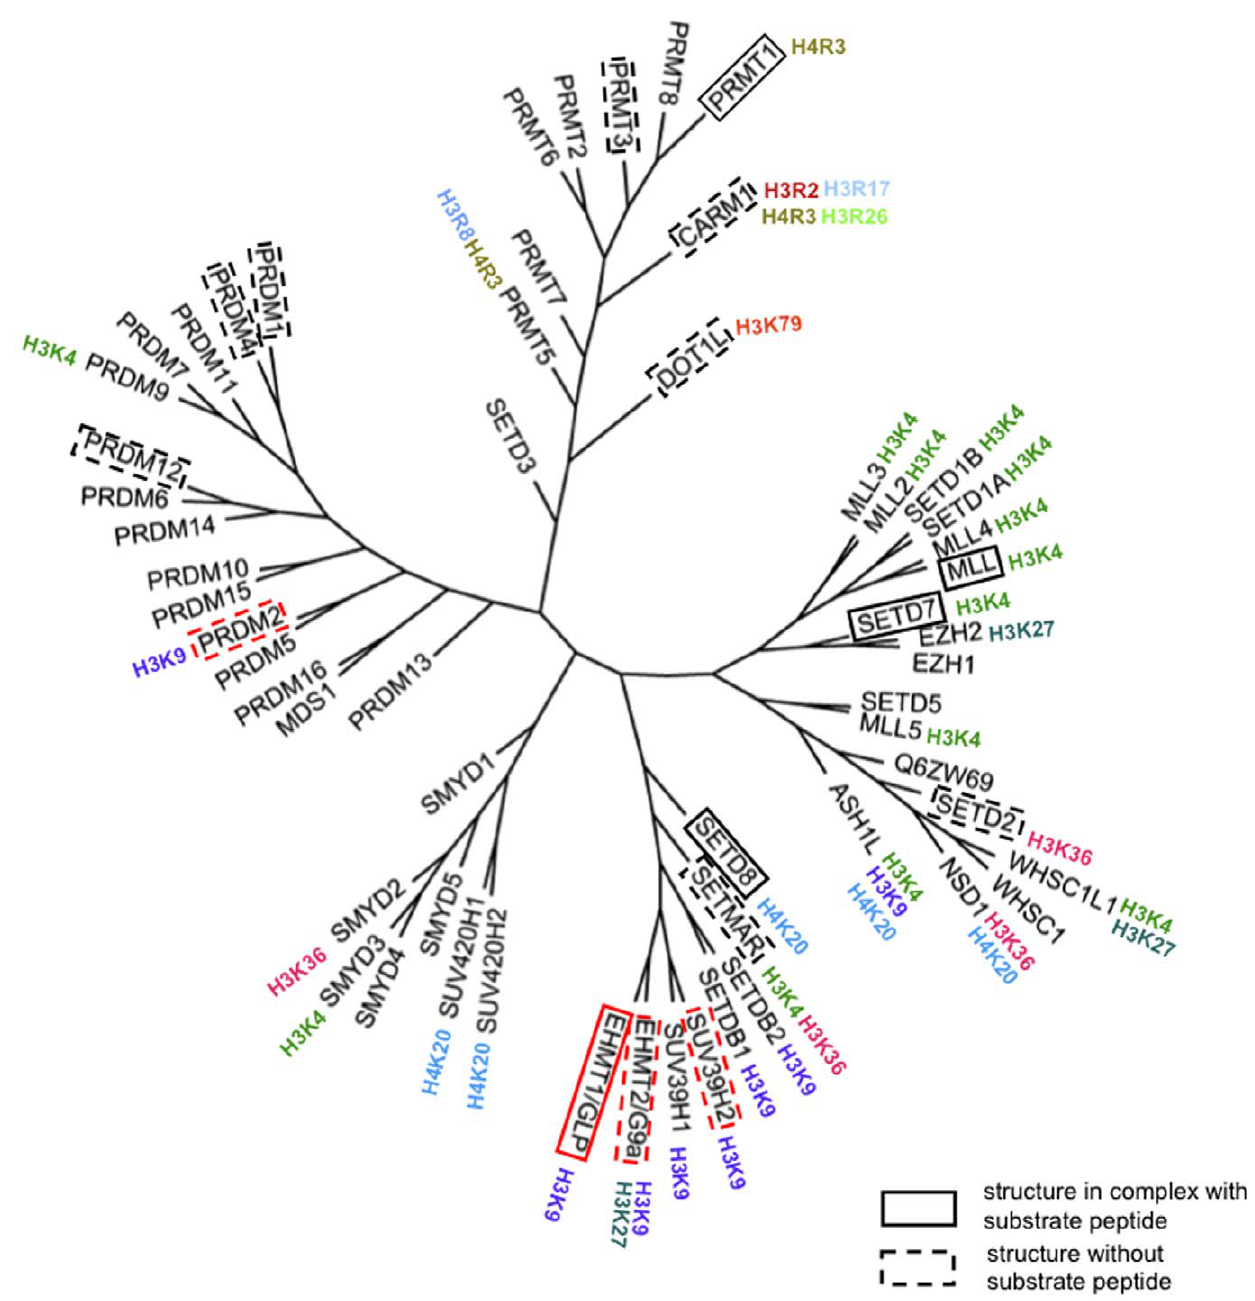
Figure 1. Phylogenetic tree of human histone methyltransferases. Phylogeny is based on a multiple sequence alignment of the methyltransferase domain including the N-SET, Pre_SET, SET, I-SET, and Post-SET motifs. Substrate selectivity was extracted from Kouzarides [1]. Enzymes with solved structure are highlighted by a frame, dotted if no peptide substrate complex is available. Structures solved in the present work are framed in red.